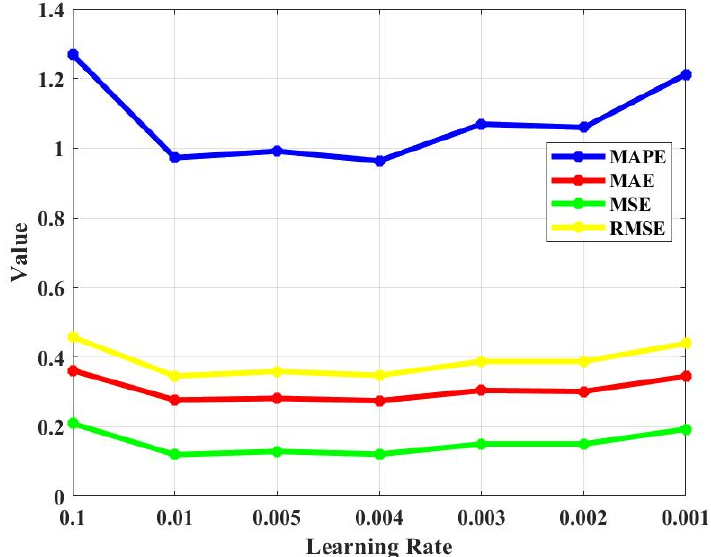
Figure 11. The experimental results of the new hybrid SST correction model in different learning rate. The units of RMSE, MAE, and MSE are °C and the unit of MAPE is %.